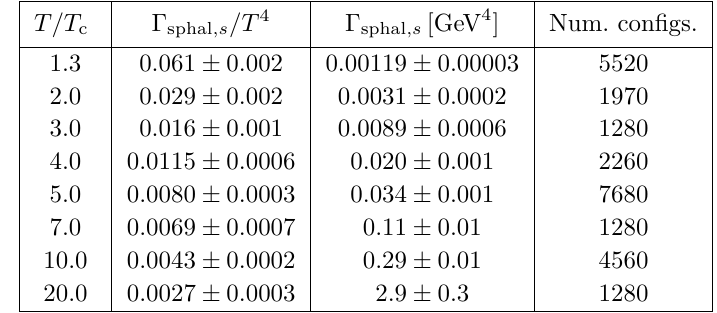
Table 2 . Results presented in figure 14 in tabular form. Errors are statistical